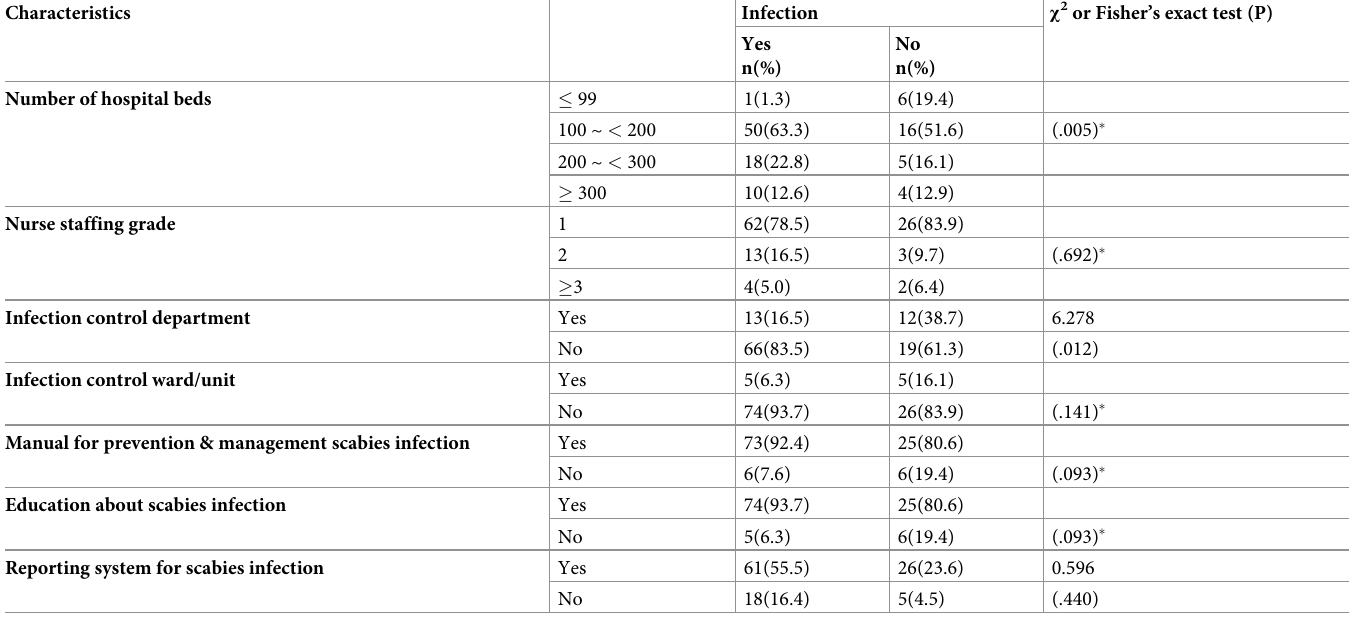
Table 5. Differences in the prevalence of scabies according to the general characteristics of the nursing homes (N = 110).